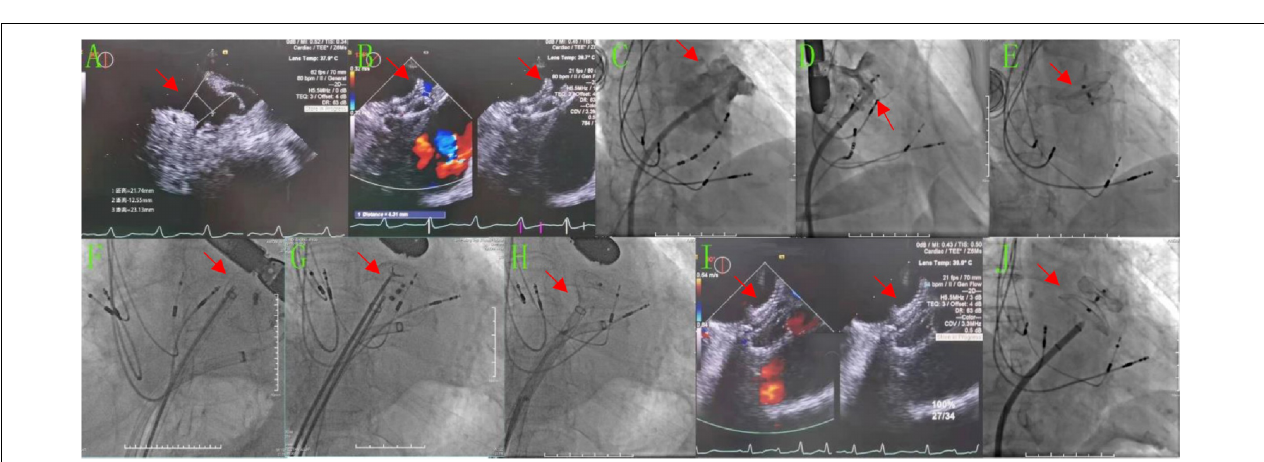
FIGURE 2 | After LAAC, the occluder detached into the LA and was retrieved, before the Lacbes 2834 device was occluded again. (A,B,I) TEE images. (A) Preoperatively, the diameter of the LAA opening was 18.3–22 mm and the diameter of the anchoring area was 16.5–24.4 mm. (B) The Lacbes 2834 was placed in LAA, the fixed column was exposed, and the residual shunt at the upper edge was 4.3 mm. (I) After the second LAAC procedure with Lacbes 2636, the covering disc adhered well and had no residual shunt. (C–H,J) DSA images. (C) Preoperatively, the diameter of the LAA change opening was 28.56 mm and the diameter